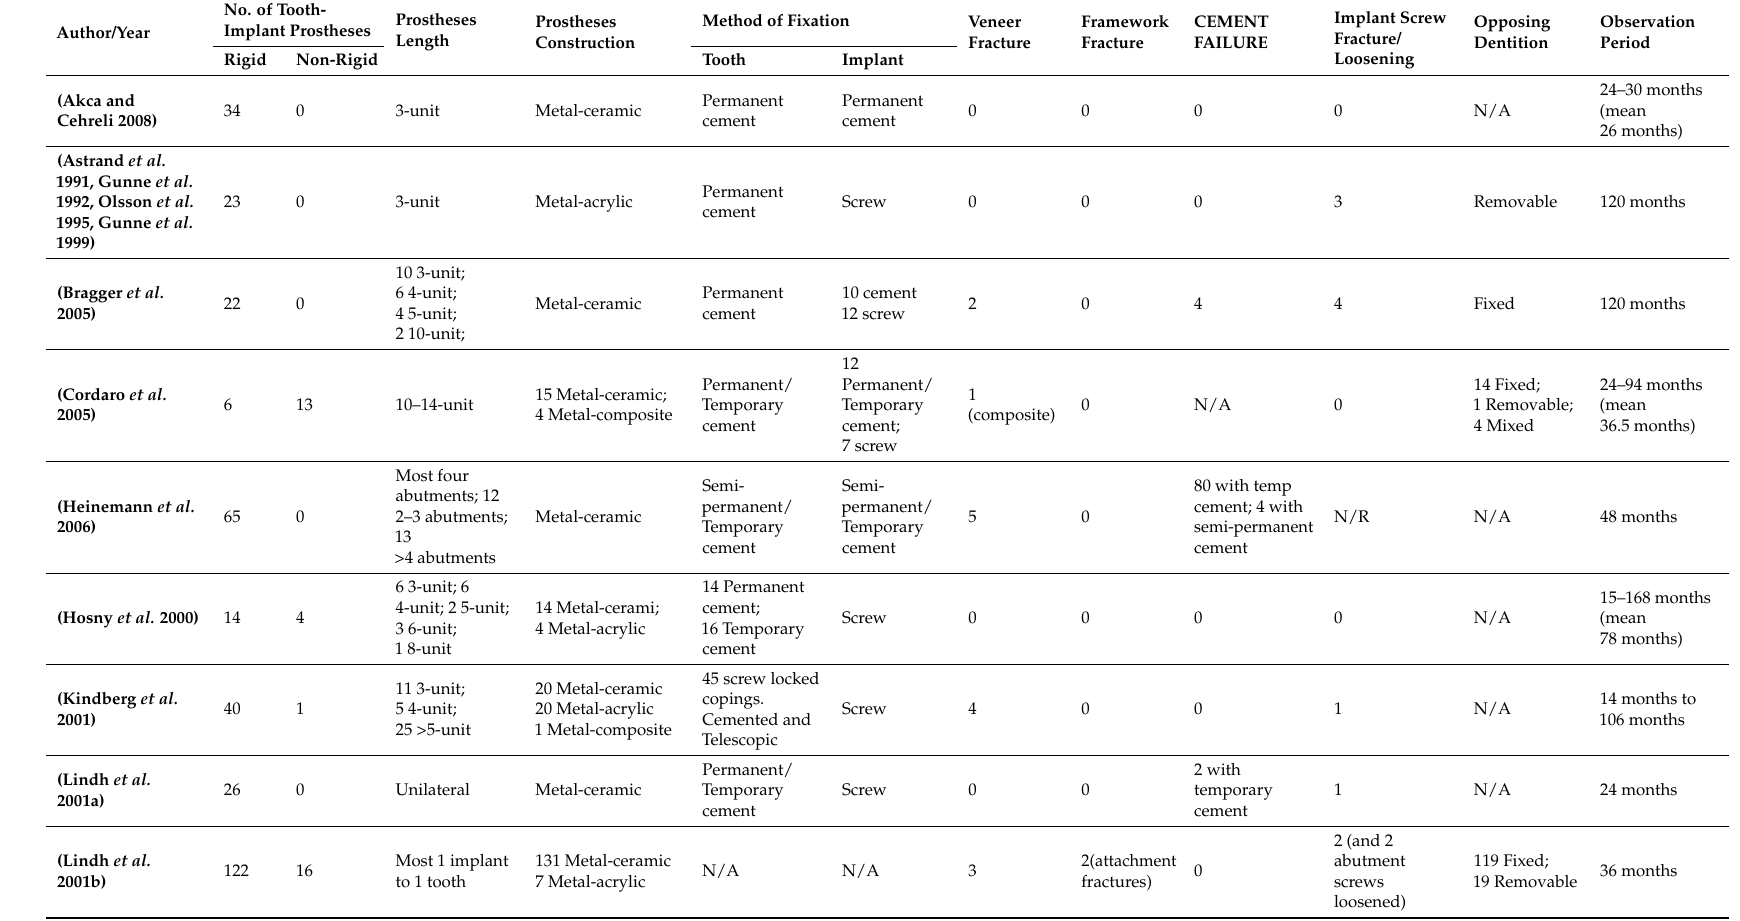
Table 6. Table of studies detailing prosthetic